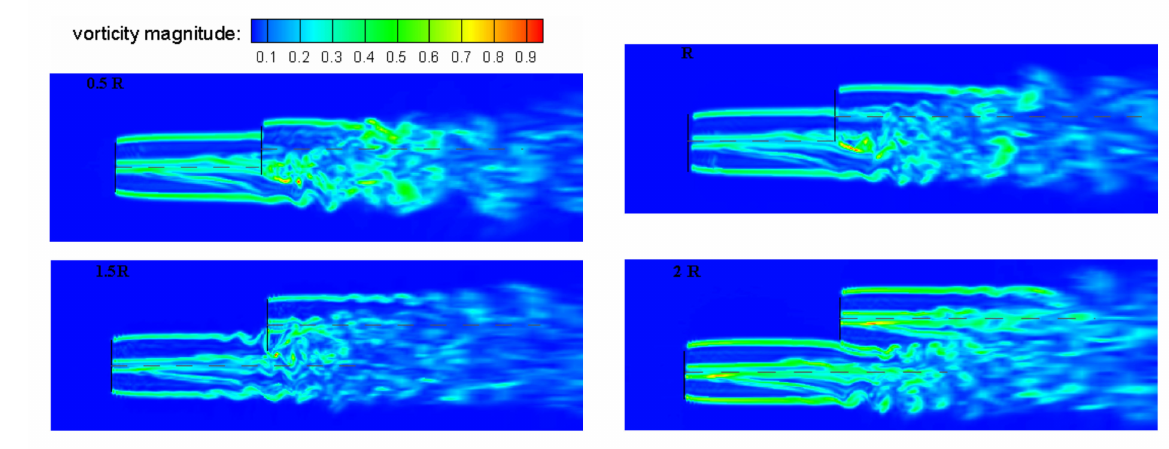
Figure 11. Vorticity contour of the horizontal section of the wind turbine center. The model wind turbine is sketched in black, and the dotted line represents the wake flow center.